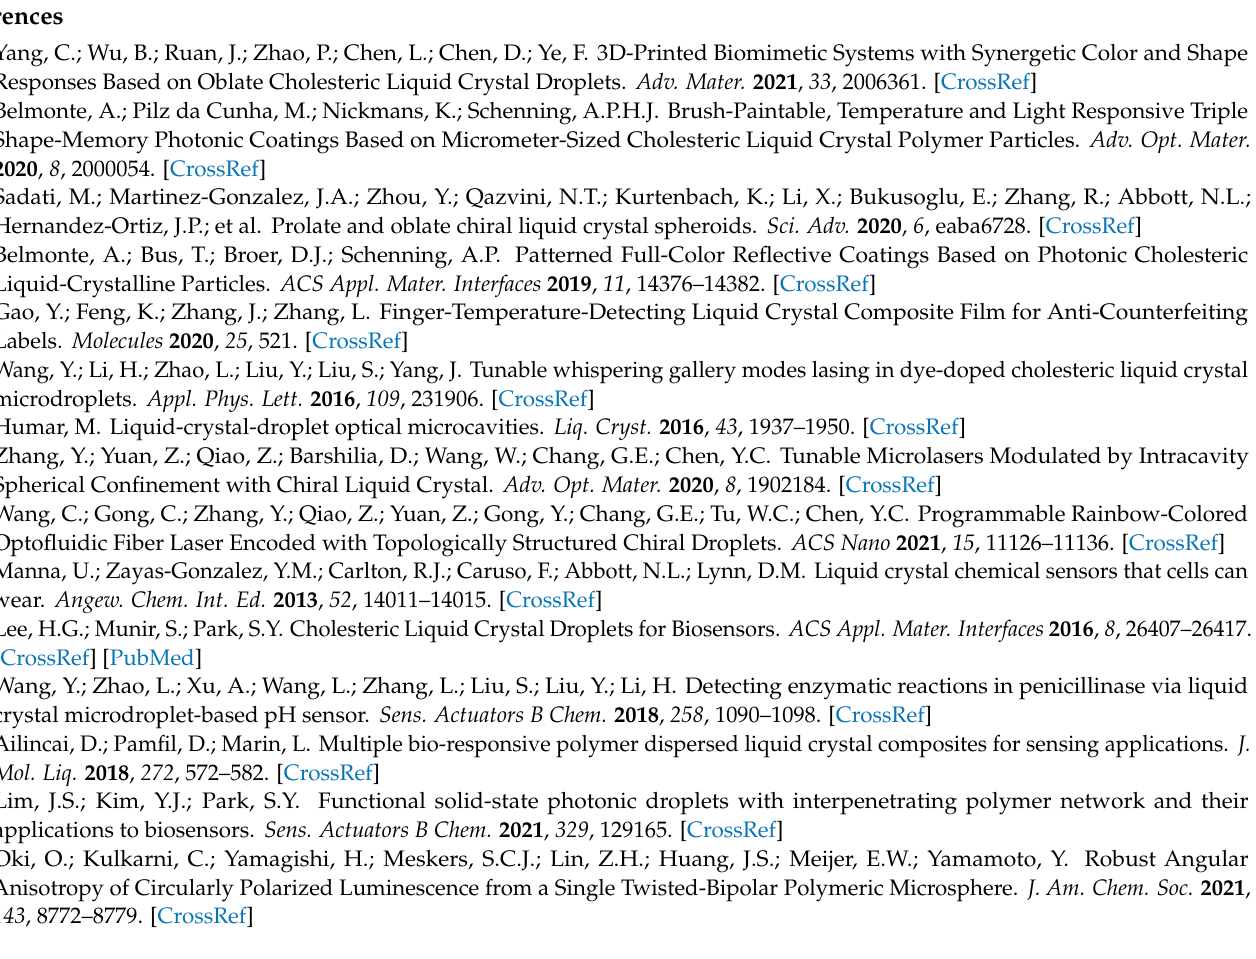
Figure S2: CLC droplets with structure with λ + 1/2 -disclination or λ − 1/2 -disclination, Video S1: Transformation of the CLC droplet structure with a stepwise decrease in applied